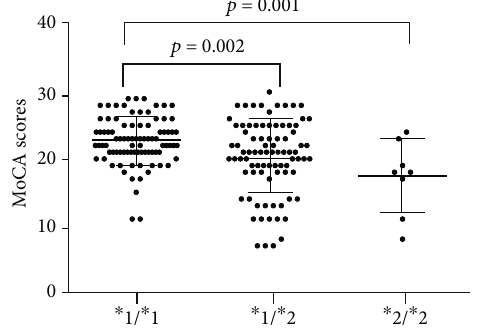
Figure 2: Comparison of Montreal Cognitive Assessment (MoCA) scores of ischemic stroke patients grouped by ALDH2